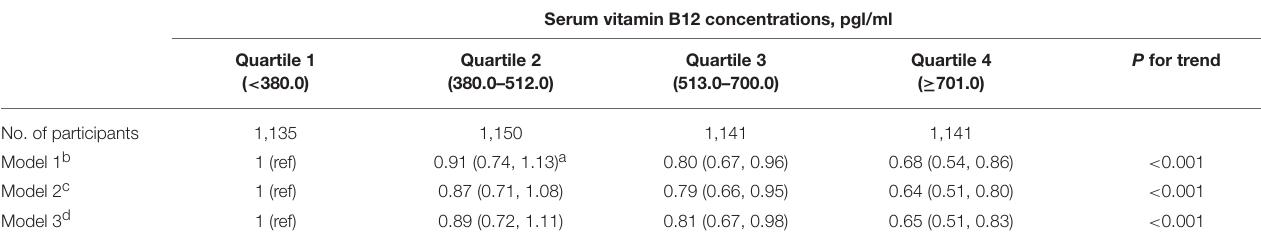
TABLE 4 | Sensitivity analysis for the association of serum vitamin B12 concentrations with obesity in 4,567 US adults fasting more than 8h. Serum vitamin B12 concentrations,